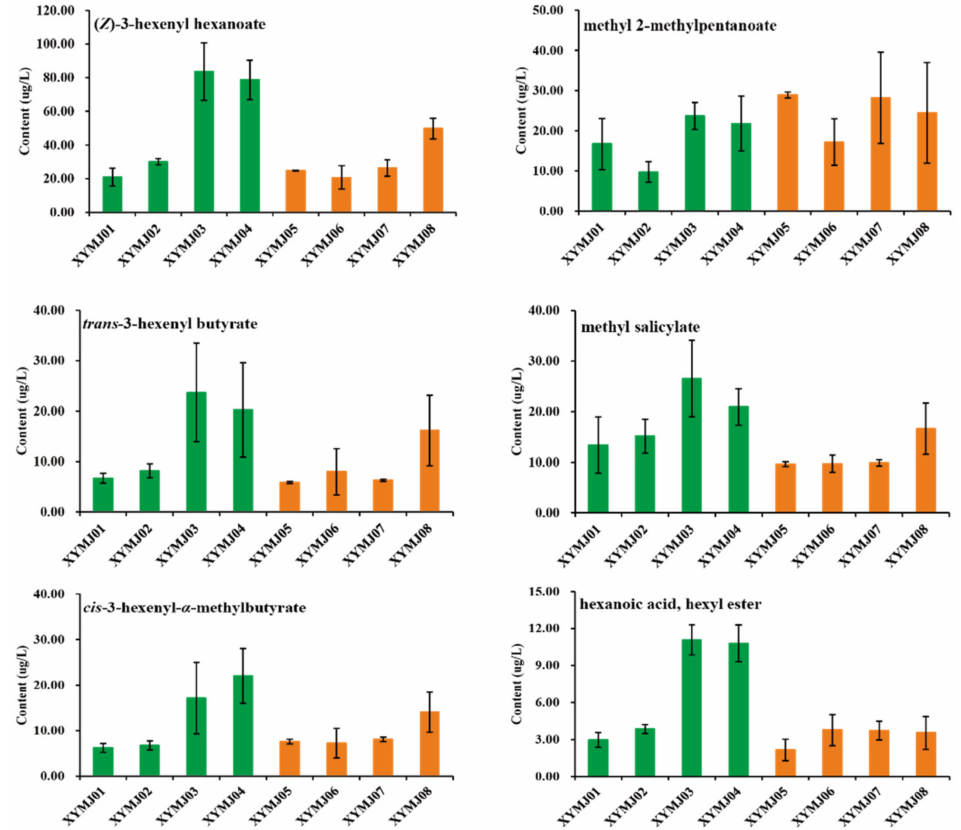
Figure 4. Various change trends of the esters in XYMJ green teas. All data are expressed as mean ± S.D. ( n =